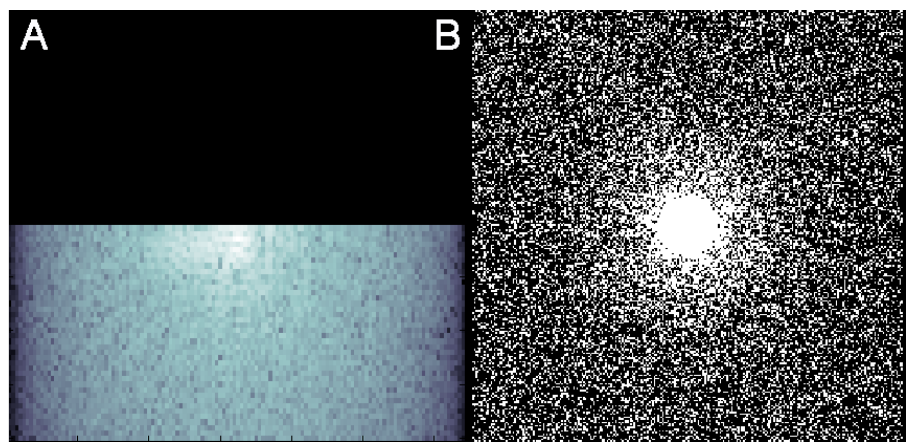
Figure 1. Undersampled k-space masks mimicking accelerated acquisition methods ( A ) Partial Fou- rier Reconstruction: 50% undersampled k-space in the phase-encoding direction, or AF = 2. ( B ) Com- pressed Sensing: 66% undersampled k-space, or AF = 3.